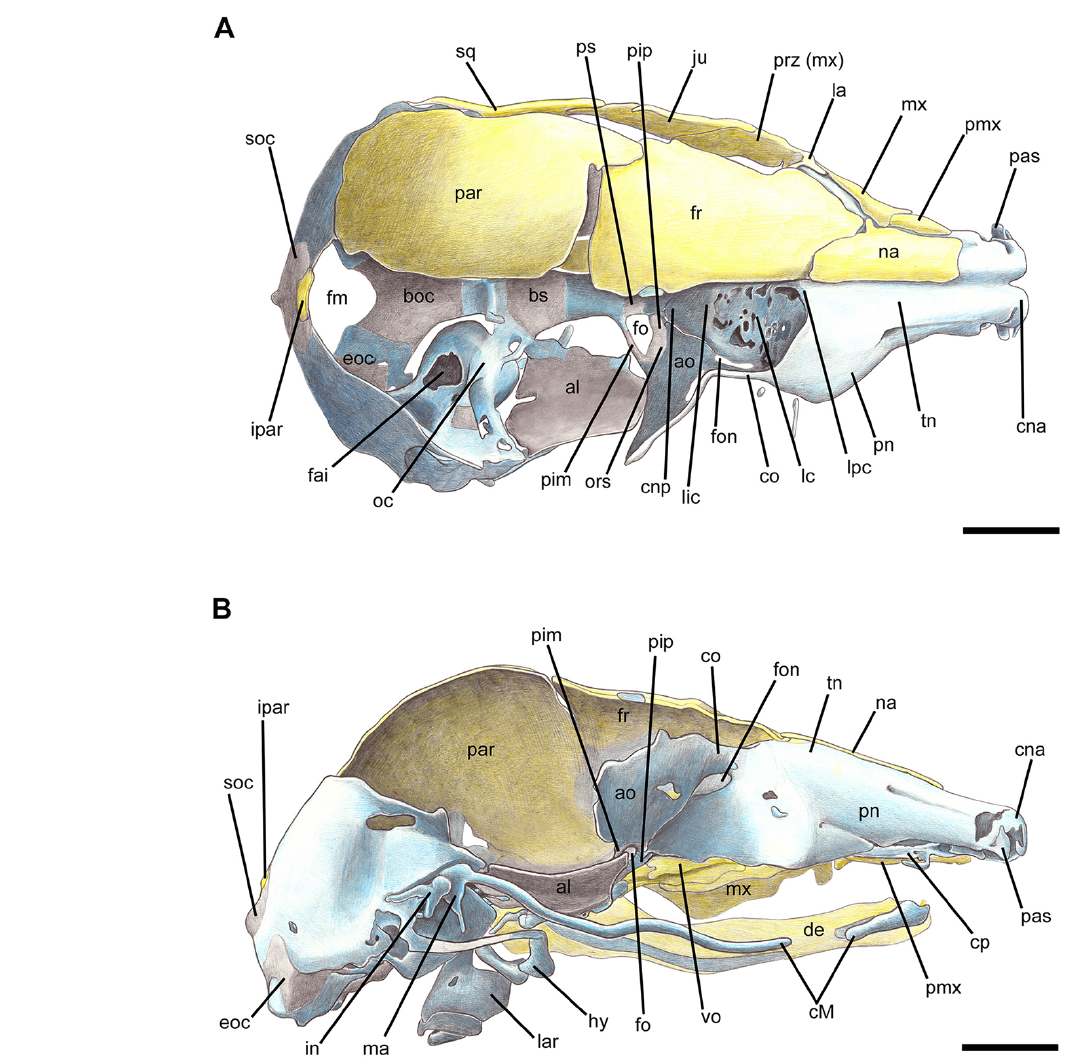
Figure 1. Three-dimensional plate model of the cranium of the fetal Ptilocercus lowii (30mm CRL): (a) dorsal view, (b) right lateral view. Reconstruction of dermal bones is restricted to left side. Cartilage is drawn in blue, dermal bones in yellow, and endochondral bone in grey. Abbreviations: al, alisphenoid; ao, ala orbitalis; boc, basioccipital; bs, basisphenoid; cM, cartilago Meckeli; can, cupula nasi anterior; cnp, cupula nasi posterior; co, commissura orbitonasalis; cp, cartilago paraseptalis; de, dentary; eoc, exoccipital; fai, foramen acusticum internum; fm, foramen magnum; fo, foramen opticum; fon, fissura orbitonasalis; fr, frontal; hy, hyoid; in, incus; ipar, interparietal; ju, jugal; la, lacrimal; lar, larynx; lc, lamina cribrosa; lic, lamina infracribrosa; lpc, limbus praecribrosus; ma, malleus; mx, maxilla; na, nasal; oc, otic capsule; ors, orbitosphenoid; par, parietal; pas, processus alaris superior; pim, pila metoptica; pip, pila praeoptica; pmx, premaxilla; pn, paries nasi; prz, processus zygomaticus; ps, presphenoid; soc, supraoccipital; sq, squamosal; tn, tectum nasi; vo, vomer. Scale bars equal